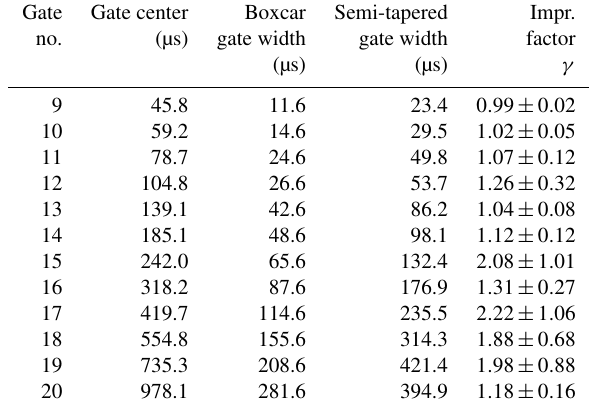
Table 1. Gate center times, gate width, improvement factors, γ , and standard deviation for gates 9 to 20. Gate widths are measured as full width at half maximum. Boxcar and semi-tapered gates have the same center time except for the last gate (20), where the table gives the center time of the boxcar gate. The corresponding semi- tapered gate center time is 910.4µs. Gate Gate center Boxcar Semi-tapered Impr.